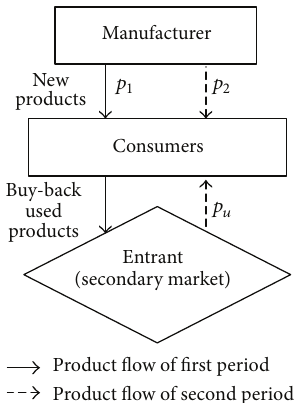
Figure 1: Two-period model